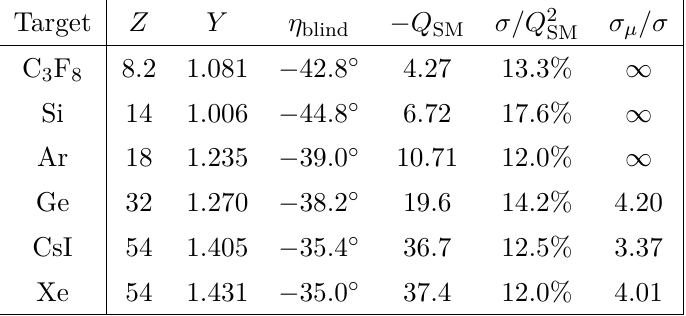
Table 1 . Number of protons Z , the neutron-to-proton ratio Y = N/Z , the corresponding blind spot η blind , eq. (2.10), and the value of the SM weak charge, Q SM , for different target materials. We use the average N corresponding to the natural isotope abundances, and for the molecules C 3 F 8 and CsI we take the average Z and N values. The last two columns show our assumptions about the measurement uncertainties obtainable at ESS, see eq.